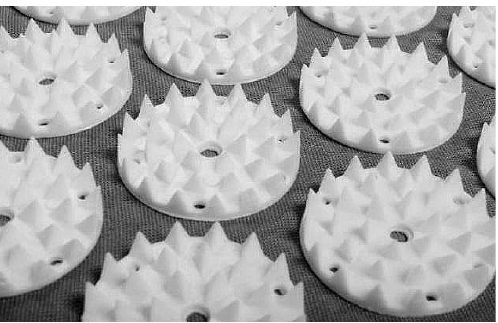
Figure 1. Detail of acupressure mat (Mysa ® ) showing characteristic plastic florets with pyramid- shaped tips on its